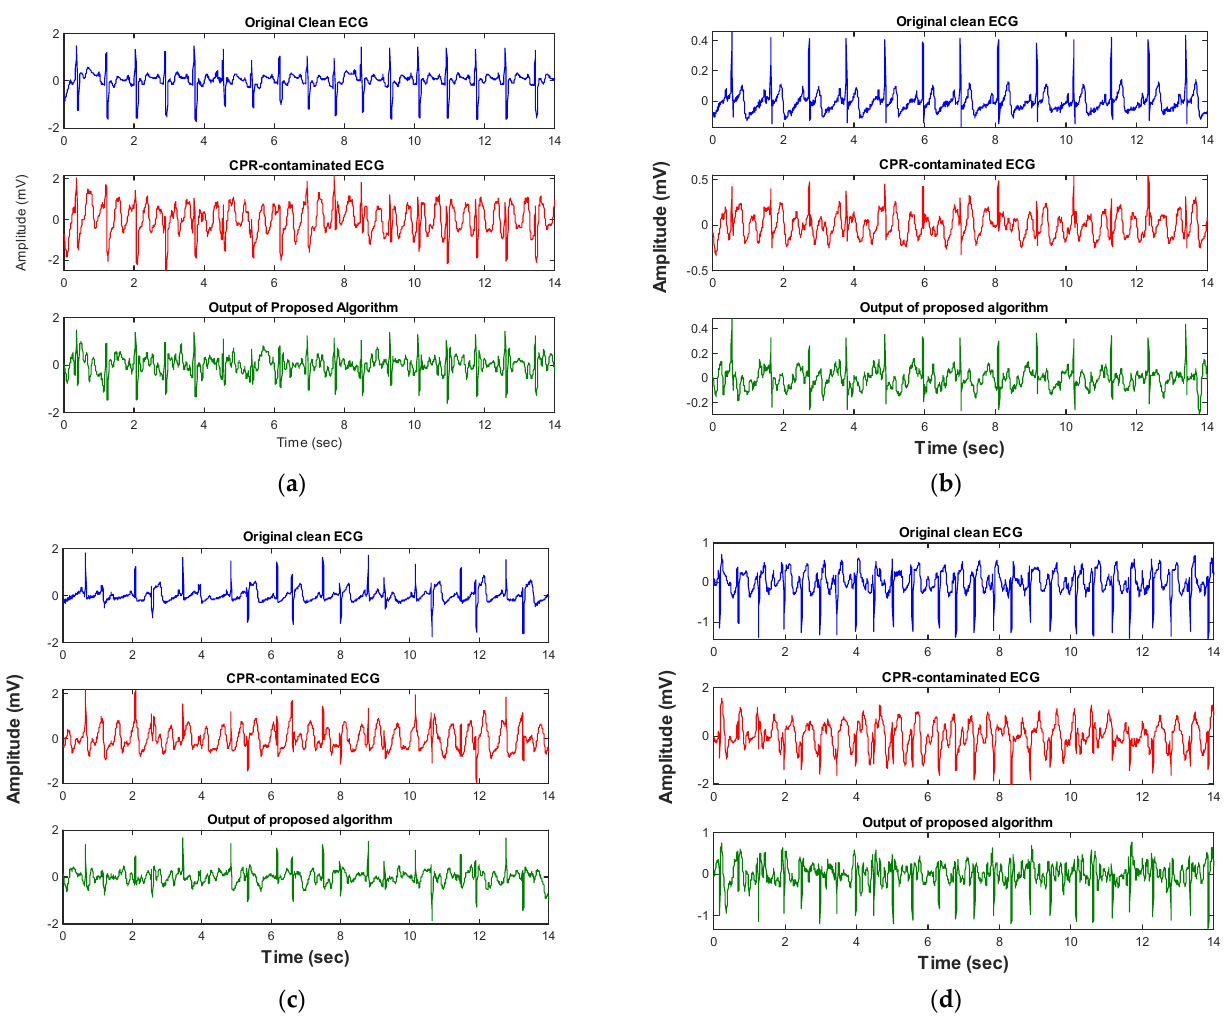
Figure 7. ( a – d ) Show the performance of the condition-based filter on four different representative non-shockable ECG rhythm types (test set). Each panel represents the ECG data segment of a different subject. Using the proposed algorithm, the SNR value improved for all rhythm types (Table